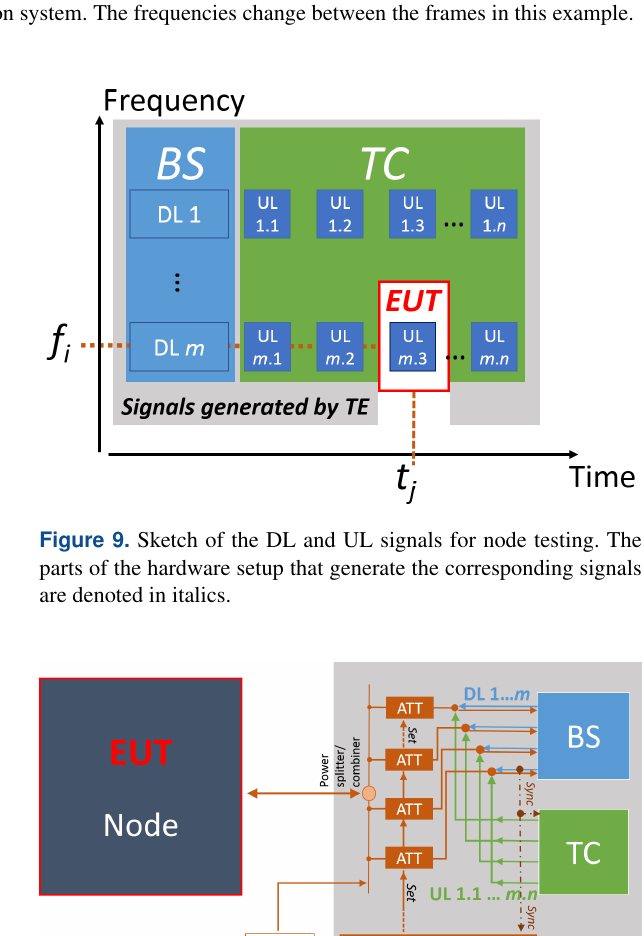
Figure 10. General test setup for node